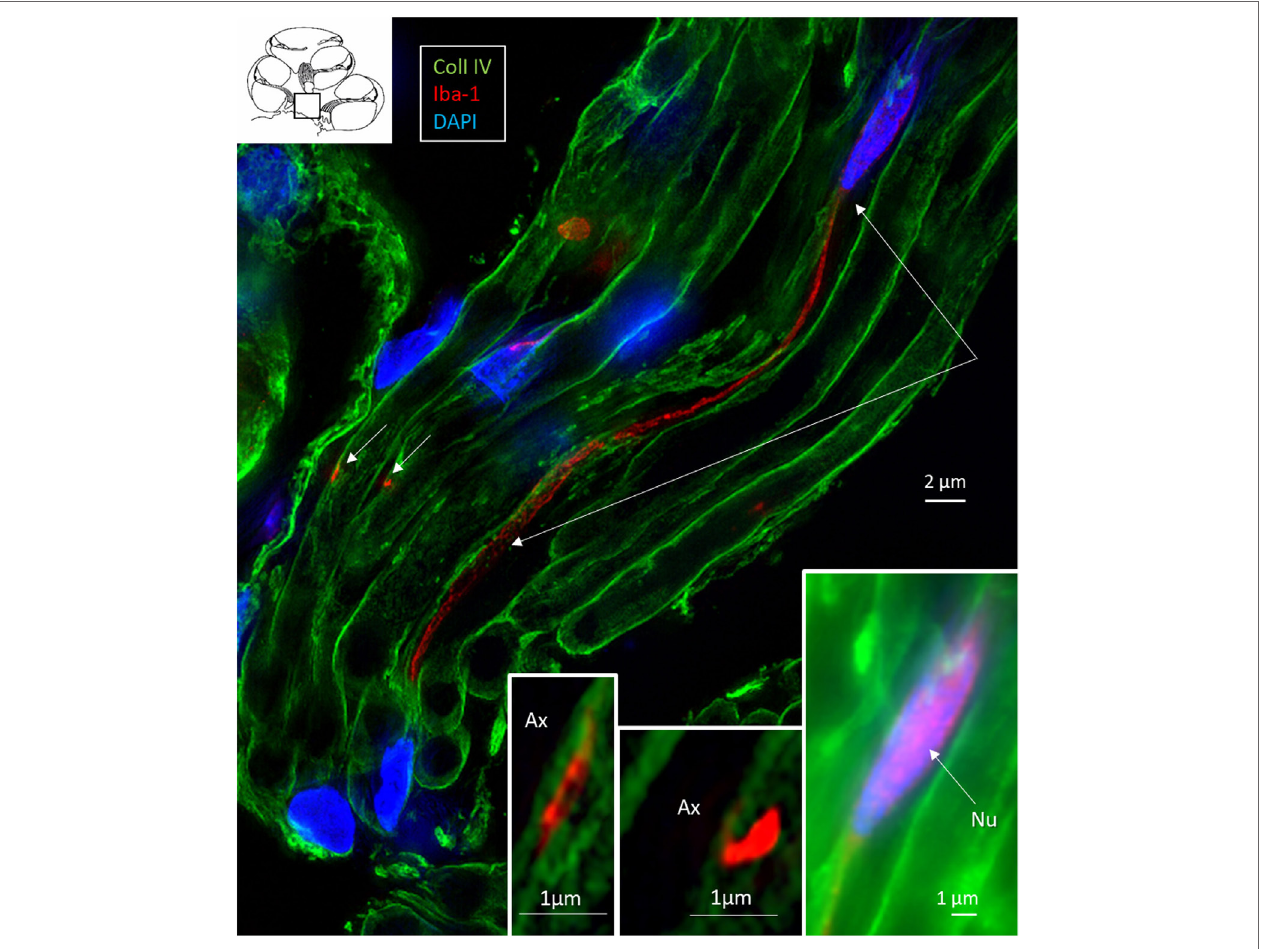
FigUre 9 | Central auditory nerve axons are connected to ionized calcium-binding adaptor molecule 1 (IBA1)-positive processes. SR-SIM (single optical section) shows IBA1-positive macrophages among central axons in the cochlea (inset, framed area). The IBA1 protein is also expressed in the nucleus (inset right). These macrophages project thin branches that contact adjacent axons (short arrows, magnified in left and middle insets). Nu,